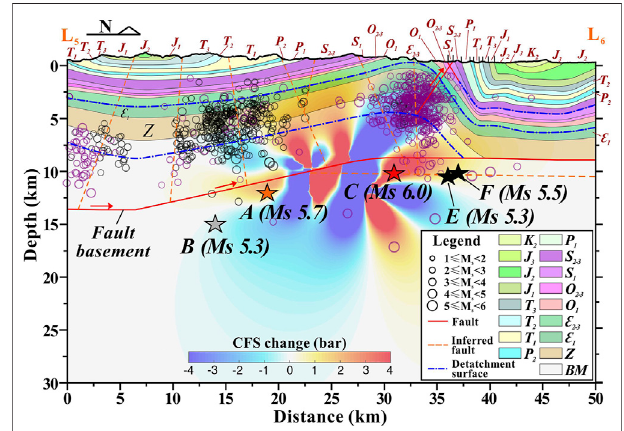
FIGURE 7 | Tectonic geological sections (Pro fi le L 5 – L 6 in Figures 1D , 5A ) with projected earthquakes within 5 km laid atop the Coulomb failure stress changes along Pro fi le L 5 – L 6 . The geological sections were drawn based on a 1:200,000 geological map and He et al. (2019). BM: Proterozoic and Archaeozoic